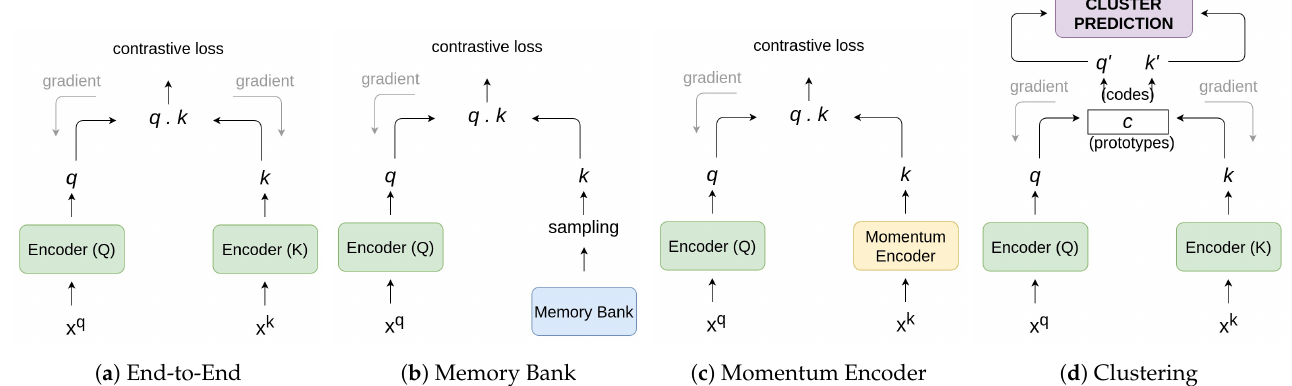
Figure 11. Different architecture pipelines for Contrastive Learning: ( a ) End-to-End training of two encoders where one generates representation for positive samples and the other for negative samples. ( b ) Using a memory bank to store and retrieve encodings of negative samples. ( c ) Using a momentum encoder which acts as a dynamic dictionary lookup for encodings of negative samples during training. ( d ) Implementing a clustering mechanism by using swapped prediction of the obtained representations from both the encoders using end-to-end